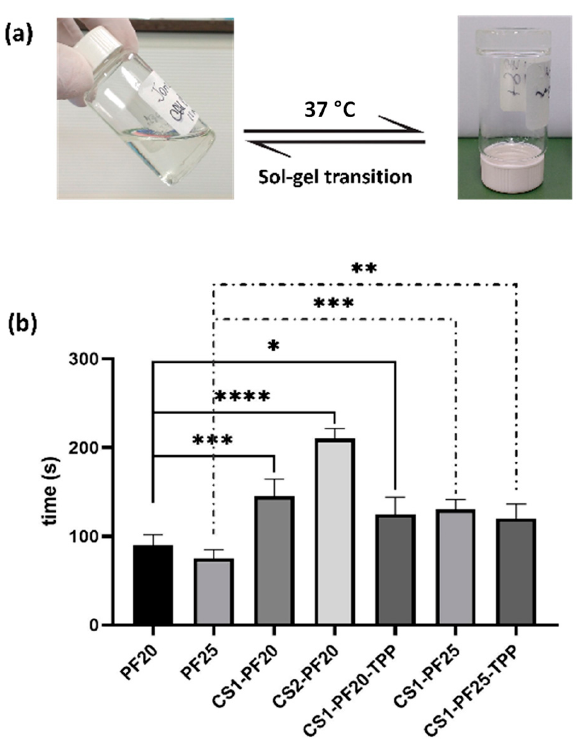
Figure 1. The sol–gel transition characteristics of a thermosensitive gel: ( a ) Phase changes with a temperature increase. ( b ) Gelation time of CS-PF hydrogels containing different CS and PF concentrations, with and without TPP. Values represent mean ± SD ( n = 5). All experiments were performed five times. (Ordinary one-way ANOVA, * p < 0.05, ** p < 0.01, *** p < 0.001 and **** p < 0.0001).